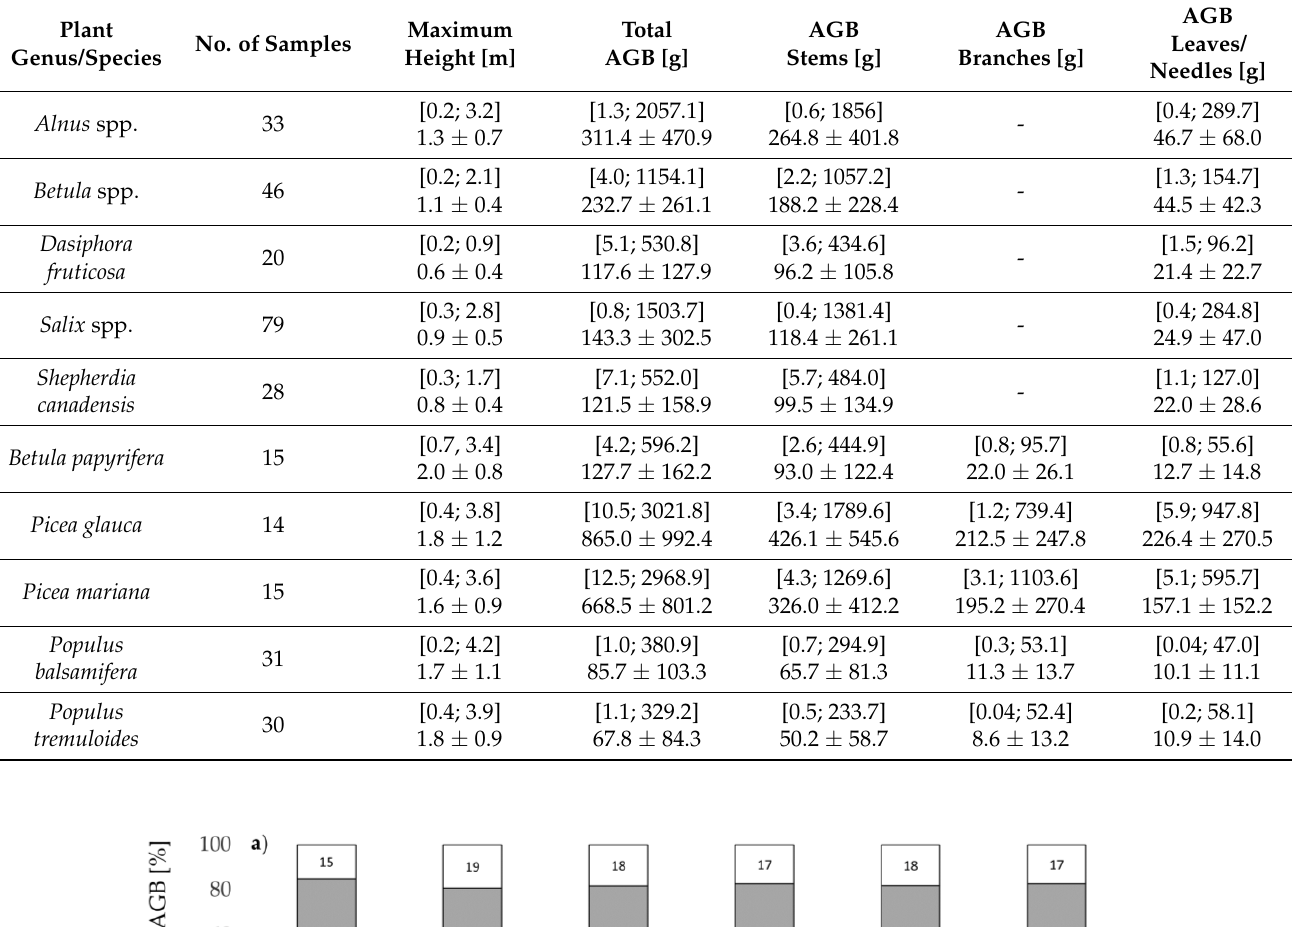
Table 1. Descriptive statistic per plant genus/species and plant component (range of values in parentheses, average ± standard deviation).